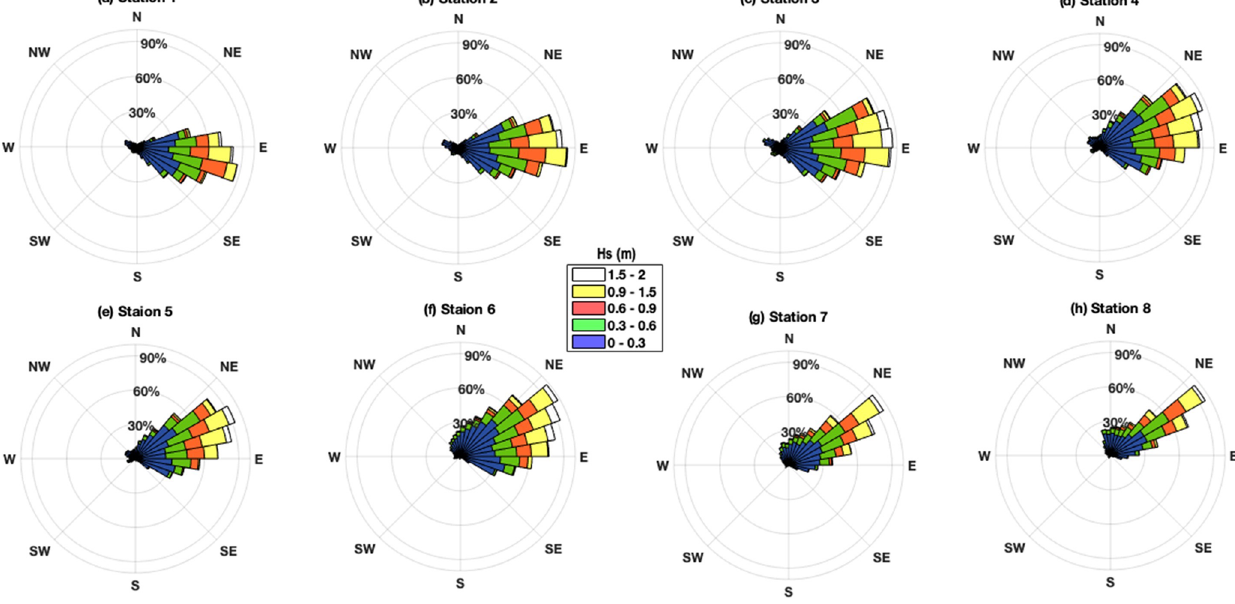
Figure 7. Nearshore wave climate: wave rose diagrams in the coastal belt of Emilia-Romagna along control points 1 to 8 (see Fig. 1c). The wave rose indicates the direction the waves come from (N: north; NE: northeast; E: east; SE: southeast; S: south; SW: southwest; W: west; NW: